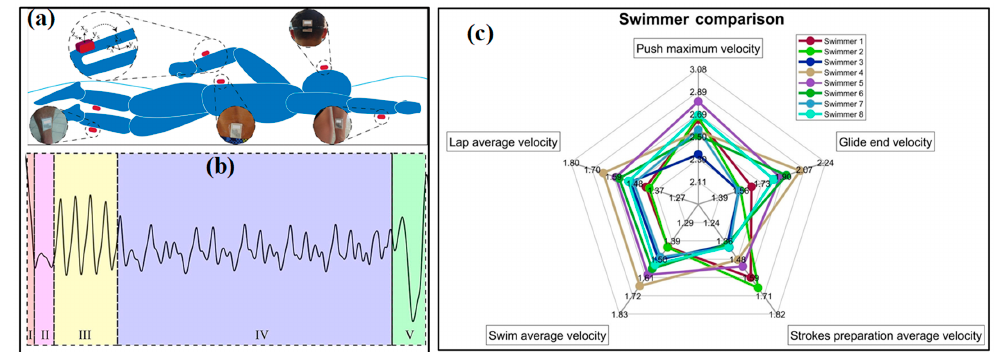
Figure 9. The applications of IMUs in sport monitoring:( a ) analyze the swimming phases of swim- mers and ( b ) obtained signals from wall to wall (I-push-off, glide, II-strokes preparation, III-IV- swimming and V-turn) [36] ; ( c ) a result from the coaching assistance system “Smartswim” [110]